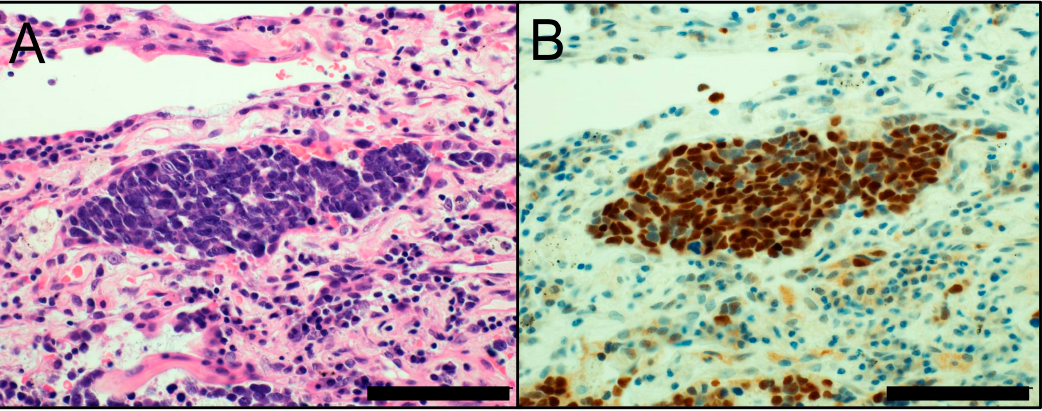
Figure 2. ( A ) Morphology of small cell lung carcinoma (hematoxylin and eosin staining); ( B ) INSM1 immunostaining (nuclear; positive). Scale bar = 100 µm.